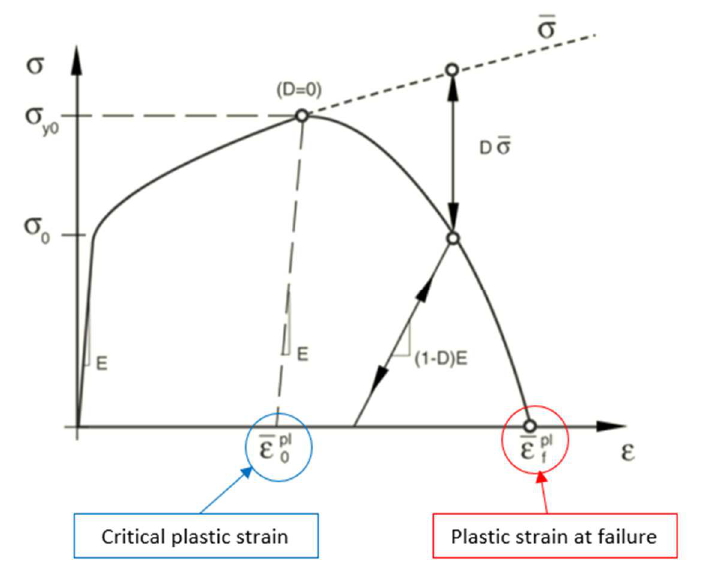
Fig. 4. Damage parameter